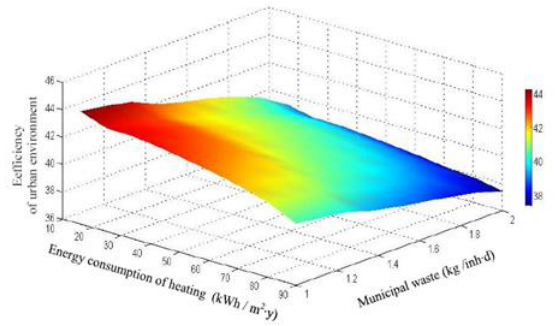
Figure 7. Dependence of the indicator of the efficiency of the urban environment in the cadastral zone of 10 m. Poltava city from the amount of energy consumed for buildings